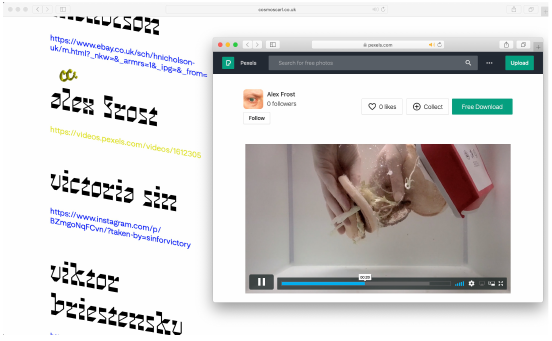
Figure 2 | Cosmos Carl_Wet Unboxing_2018_Alex Frost In this respect, Cosmos Carl foregrounds a complex understanding of the platform not simply as a “networked repository or connective archive”, but crucially as a mechanism of cultural production and as an “apparatus that observes the world and generates ordering statements” (McKenzie